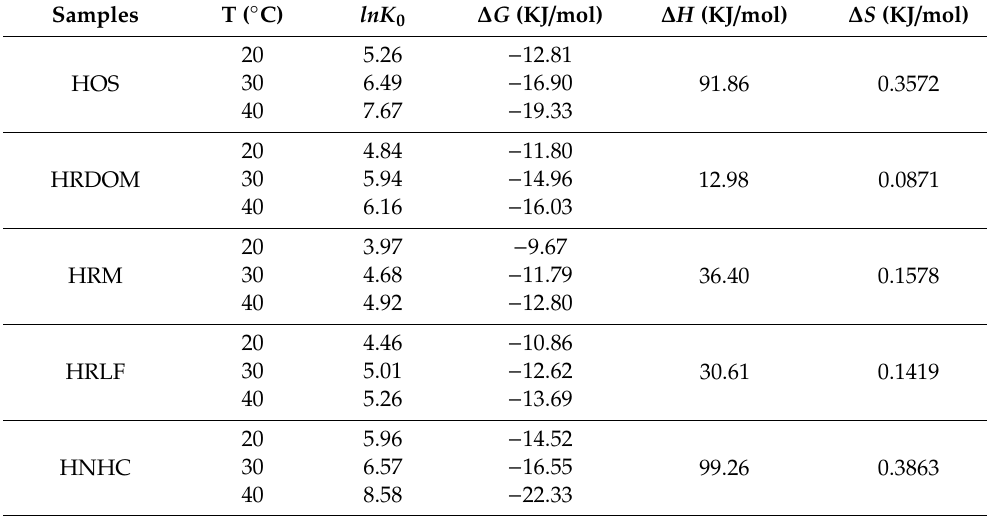
Table 5. The parameters of adsorption thermodynamics.